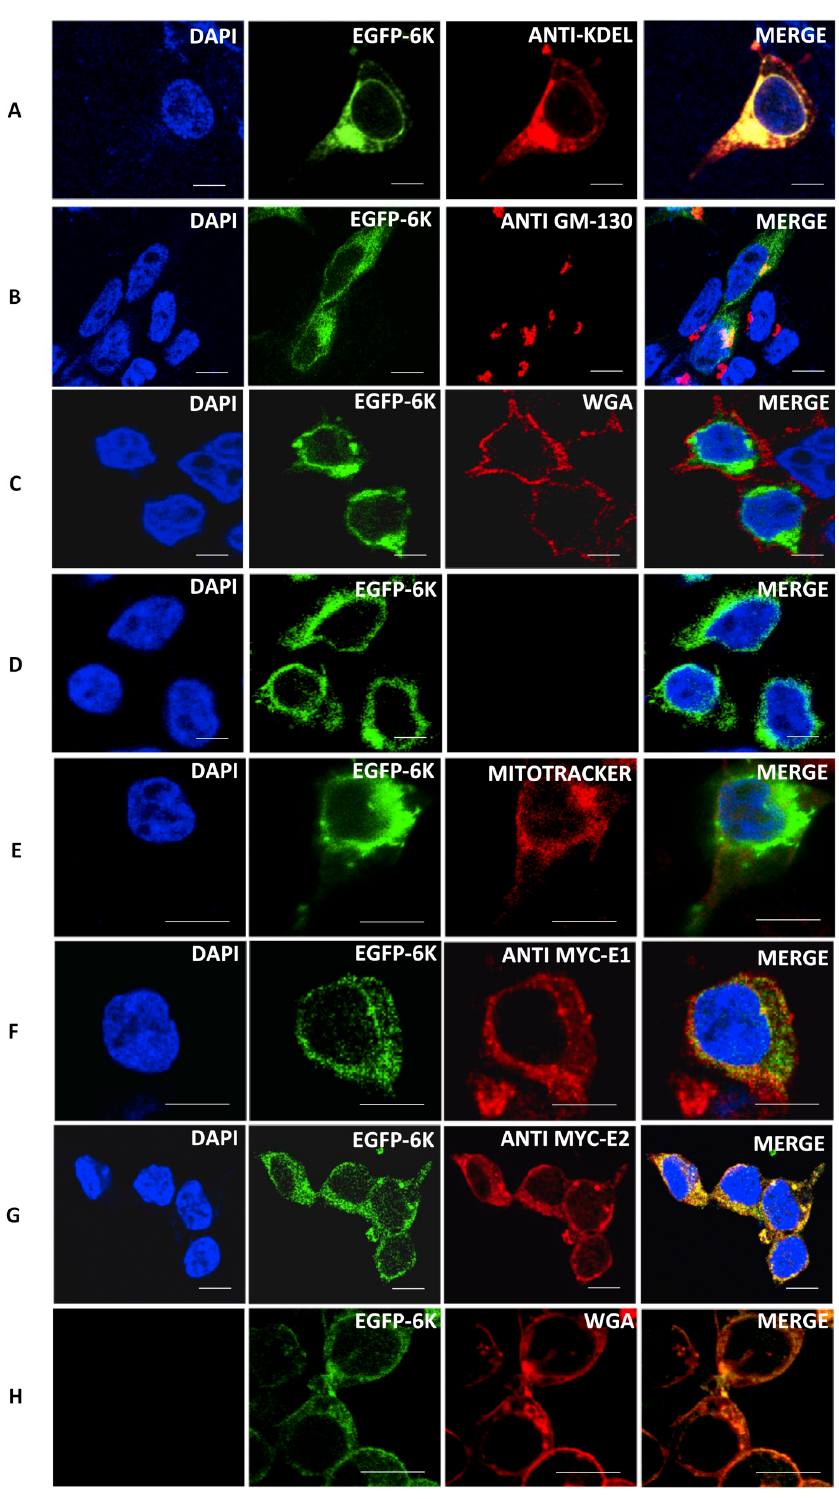
Fig 4. Mammalian cell expression of EGFP-6K shows predominant ER expression: Confocal microscopy images of HEK293T cells expressing EGFP-6K alone or in conjunction with myc-E1 and/or myc-E2 glycoproteins. Panels (A-E) show images of cells expressing EGFP-6K and stained with fluorescent markers corresponding to ER (A, anti- KDEL, red), golgi (B, GM-130, red), plasma membrane (C, red, WGA), nucleus (D, DAPI, blue) and mitochondria